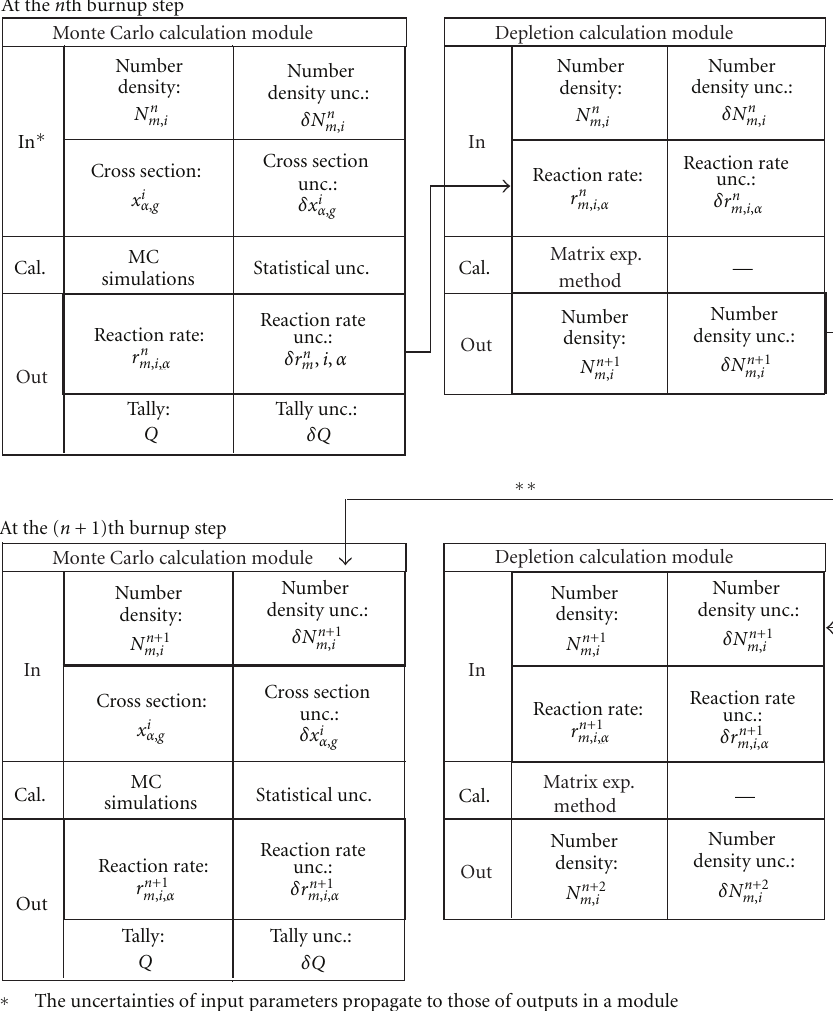
Figure 1: Uncertainty propagation in the MC burnup